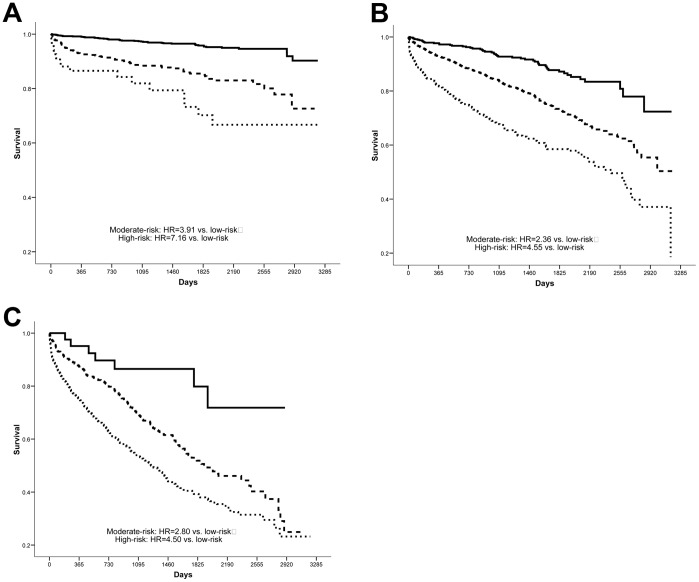
Females.Kaplan-Meier survival curves for the association of follow-up IMRS (low- [solid line], moderate- [dashed], and high-risk [dotted]) with mortality among females within strata defined by: A) low-risk baseline IMRS, B) moderate-risk baseline IMRS, and C) high-risk baseline IMRS (all p<0.001).